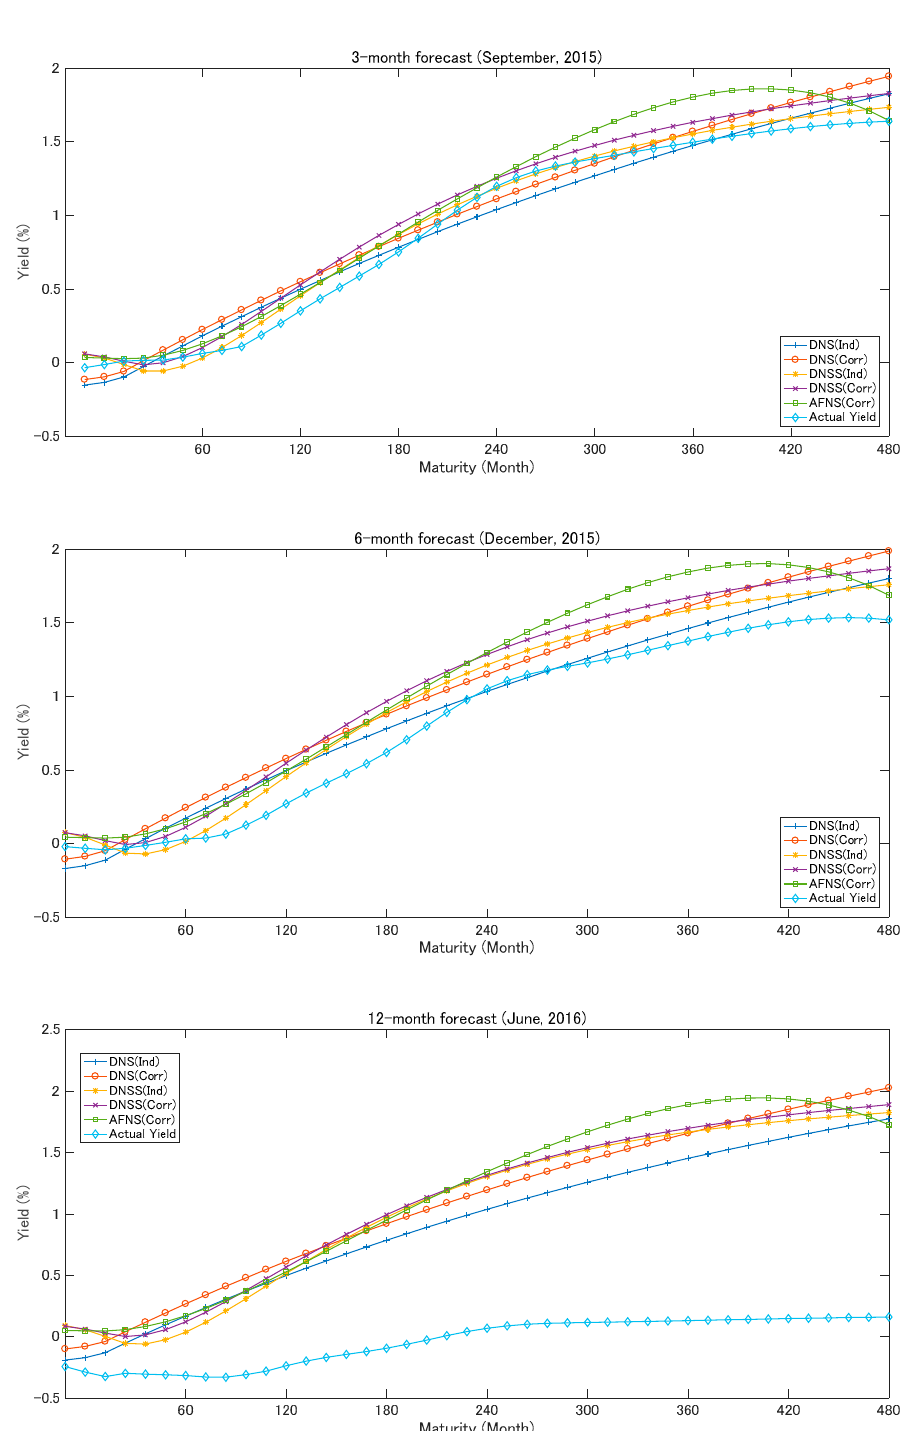
Figure 3. Forecast yields for 3-, 6-, and 12-month forecasts. Note: The notation “Ind” denotes the independent factor model and the notation “Corr” denotes the correlated factor model. The plots show the forecast yields of each model and the actual yield in September 2015; December 2015; and June 2016.